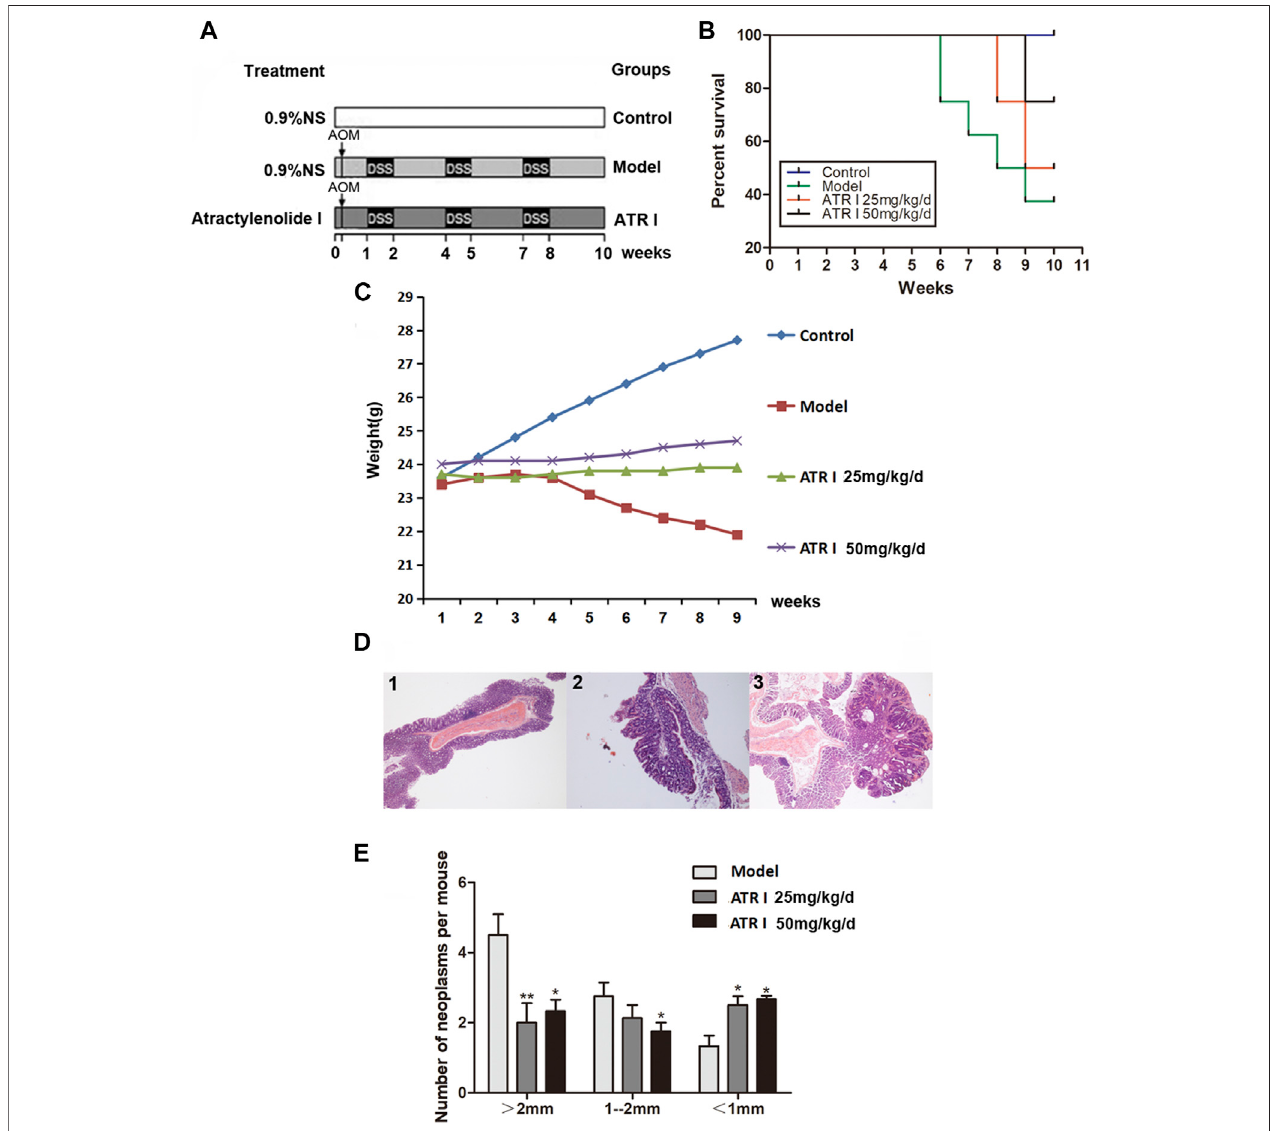
FIGURE 3 | Atractylenolide I reduced the incidence and multiplicity of colonic neoplasmsof mice treated with AOM/DSS. (A) Experimental protocol for the mice model of colon cancer associated with colitis. (B) Effect of atractylenolide I on the survival ratio of mice. (C) The effect of atractylenolide I on the weight of mice